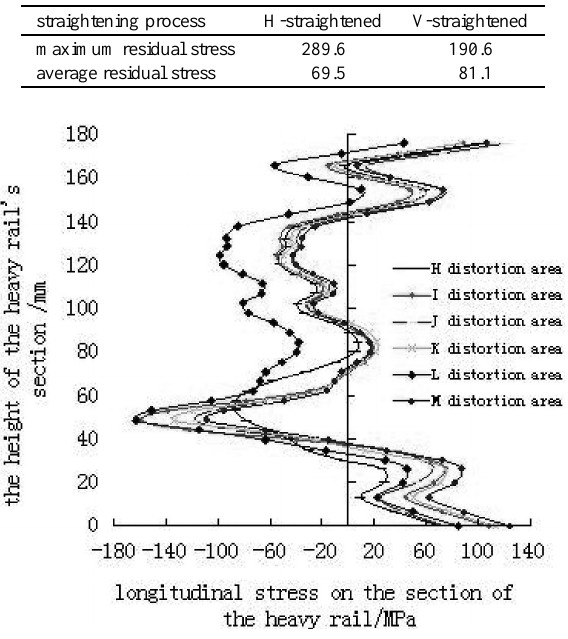
Table 3 The rail bottom residual stress (unit:MPa)